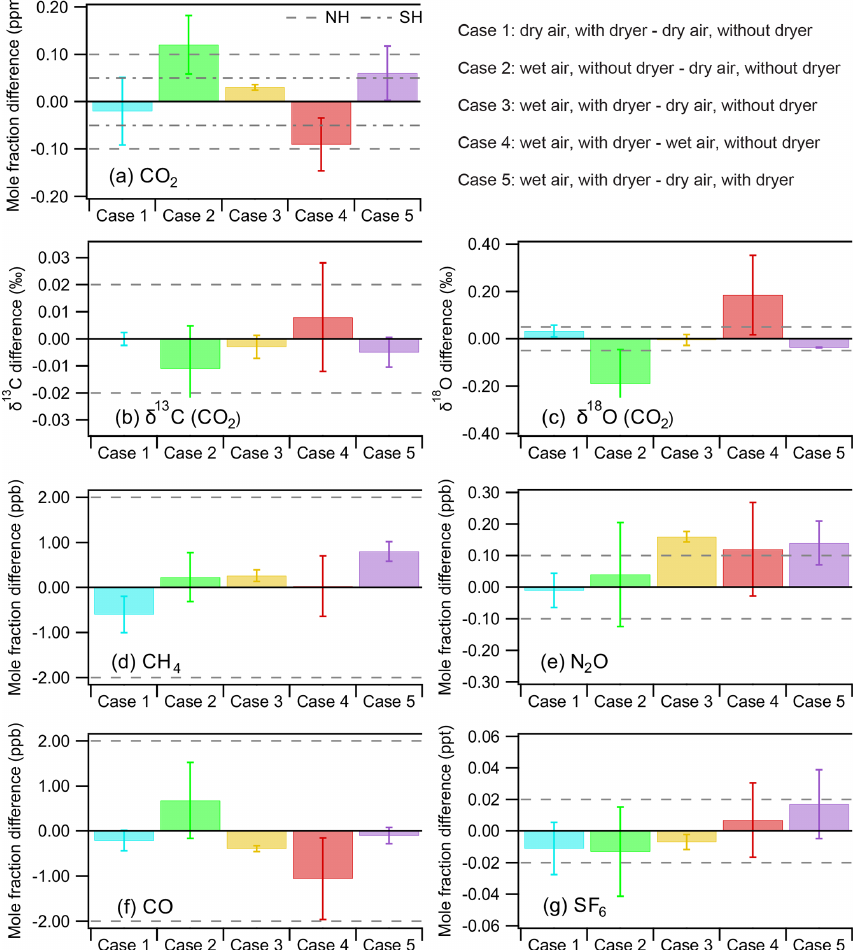
Figure 6. Overview of results to determine the effect of the NAD on the mole fraction determination of CO, CH 4 , N 2 O and SF 6 along with CO 2 and isotopic composition of its two singly substituted isotopologues ( 16 O 13 C 16 O and 16 O 12 C 18 O). The dashed lines denote the WMO network compatibility goals for the different species. We note that the compatibility goal for N 2 O should be seen as a lower limit target value. We present five test cases to illustrate the measurement biases introduced if samples are not sufficiently dried. Case 1 shows the effect of the NAD in dry conditions, whereas cases 3 and 5 show the difference in sampling of wet sample air dried with the NAD before being compressed into the sample flask with respect to dry air sampling. The worst sampling conditions with the largest bias are associated with using humidified sample air (without NAD) shown in cases 2 and 4. When the difference remains within the WMO network compatibility goals, we concluded that the measured difference is not significant (notably for cases 1, 3 and 5 for most